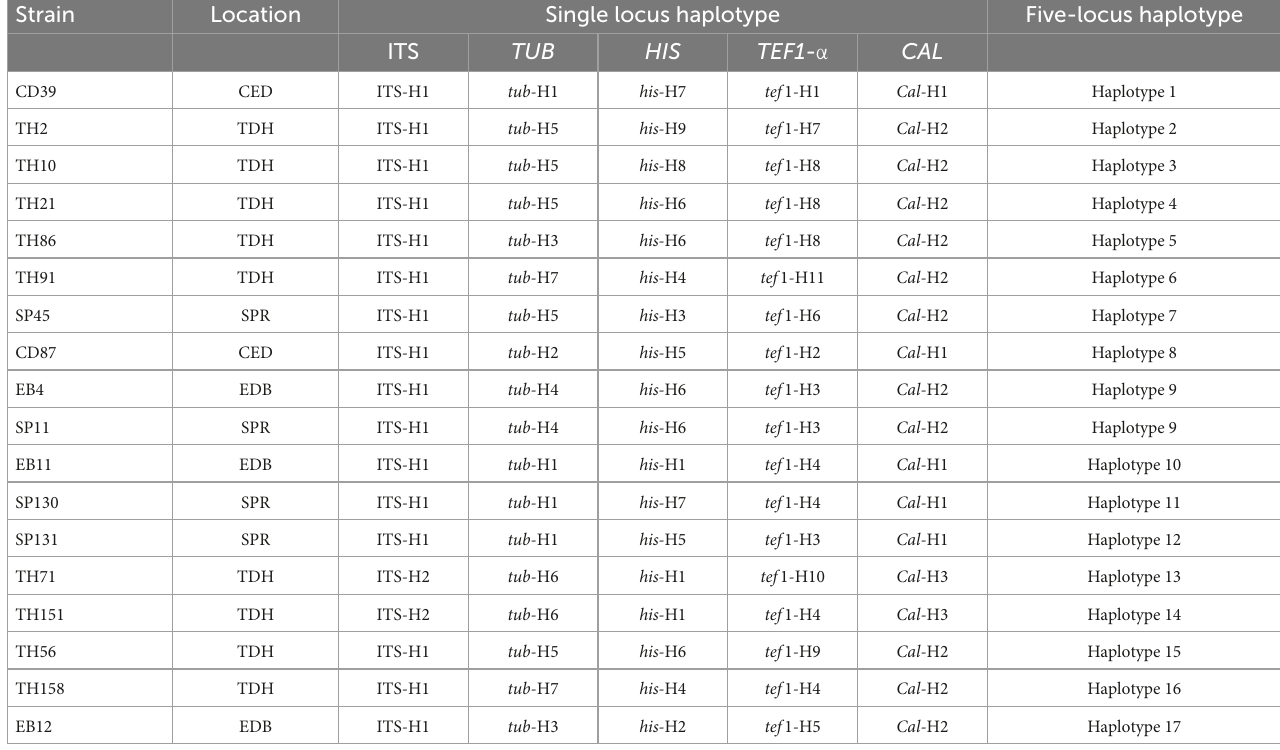
TABLE 4 Haplotypes of Diaporthe atlantica strains isolated from roots of Festuca rubra subsp. pruinosa . Strain